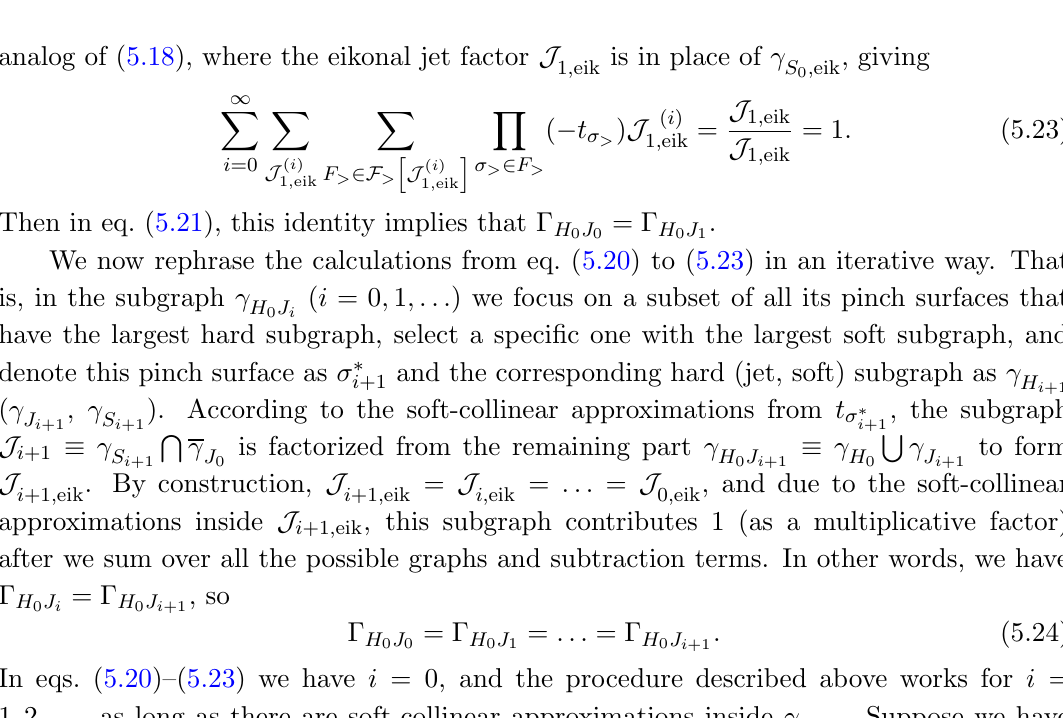
Figure 34. The pictorial representation of eq. (5.20). The l.h.s. describes the subgraphs (cid:13) (enclosed by dashed curves) and J 1 (shaded area). Note that (cid:13) with (cid:13) as well, which is not drawn in the (cid:12)gure. The r.h.s. describes the factorized expression. H 0 Due to the soft-collinear approximations sc ( (cid:27) (cid:3) 1 ) , J 1 can be rewritten as J 1 ; eik , which is decoupled from the rest of (cid:13) J 0